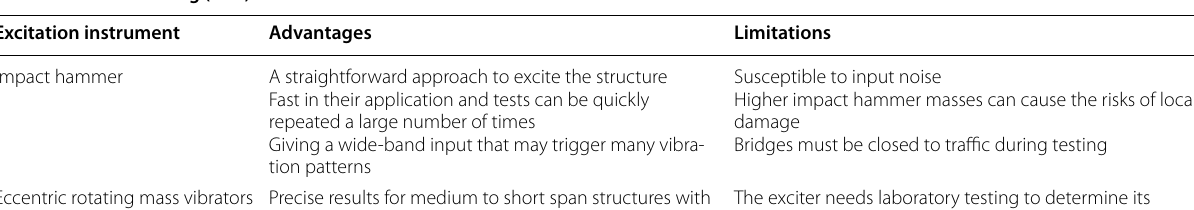
Table 1 Summarisation of the advantages and limitations of the force vibration test Forced vibration testing